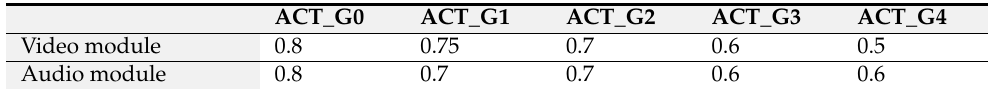
Table 2. Matching degree distribution